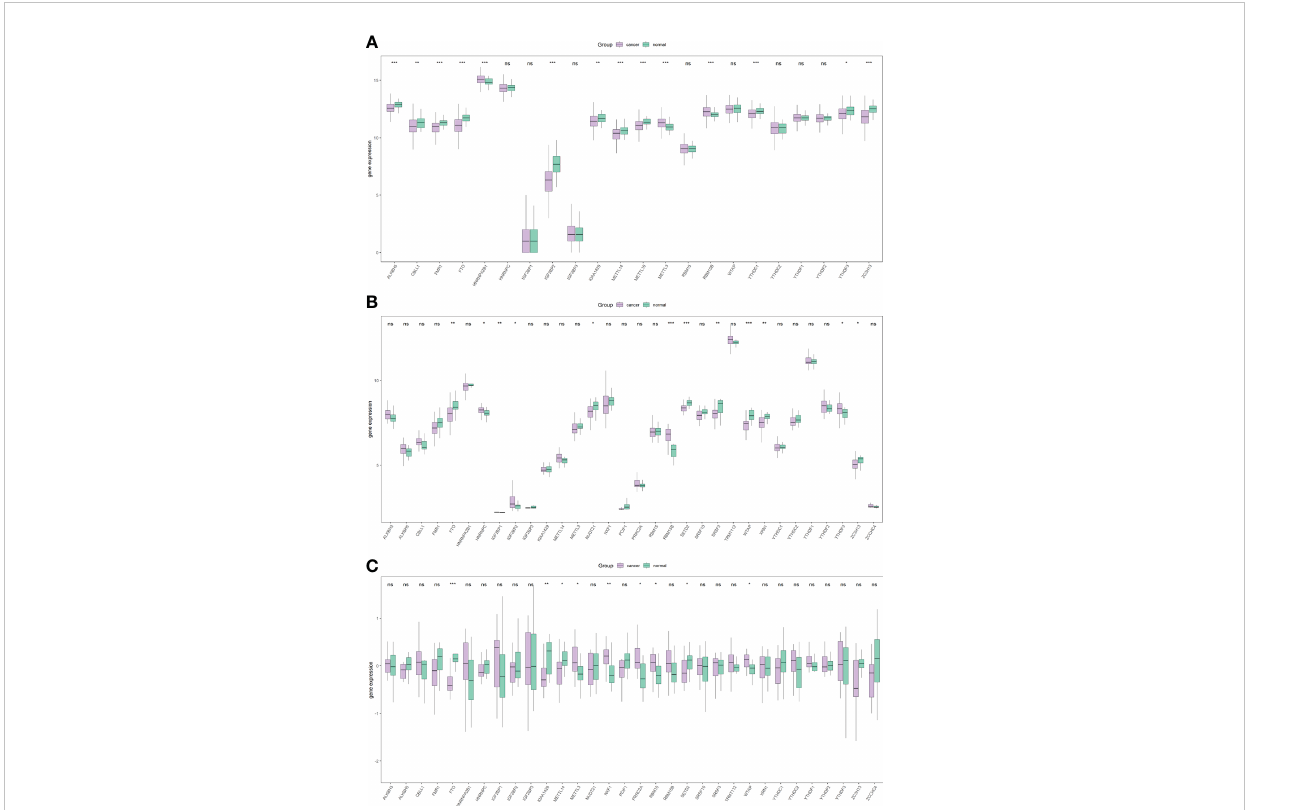
FIGURE 2 Overall expression of m 6 A-related genes in PRAD patients. Purple indicates the tumor sample, and green indicates the normal sample. Three images indicate TCGA (A) , GSE46602 (B) , GSE69223 (C) . *P < 0.05, **P < 0.01, ***P < 0.001, ns, not signi fi